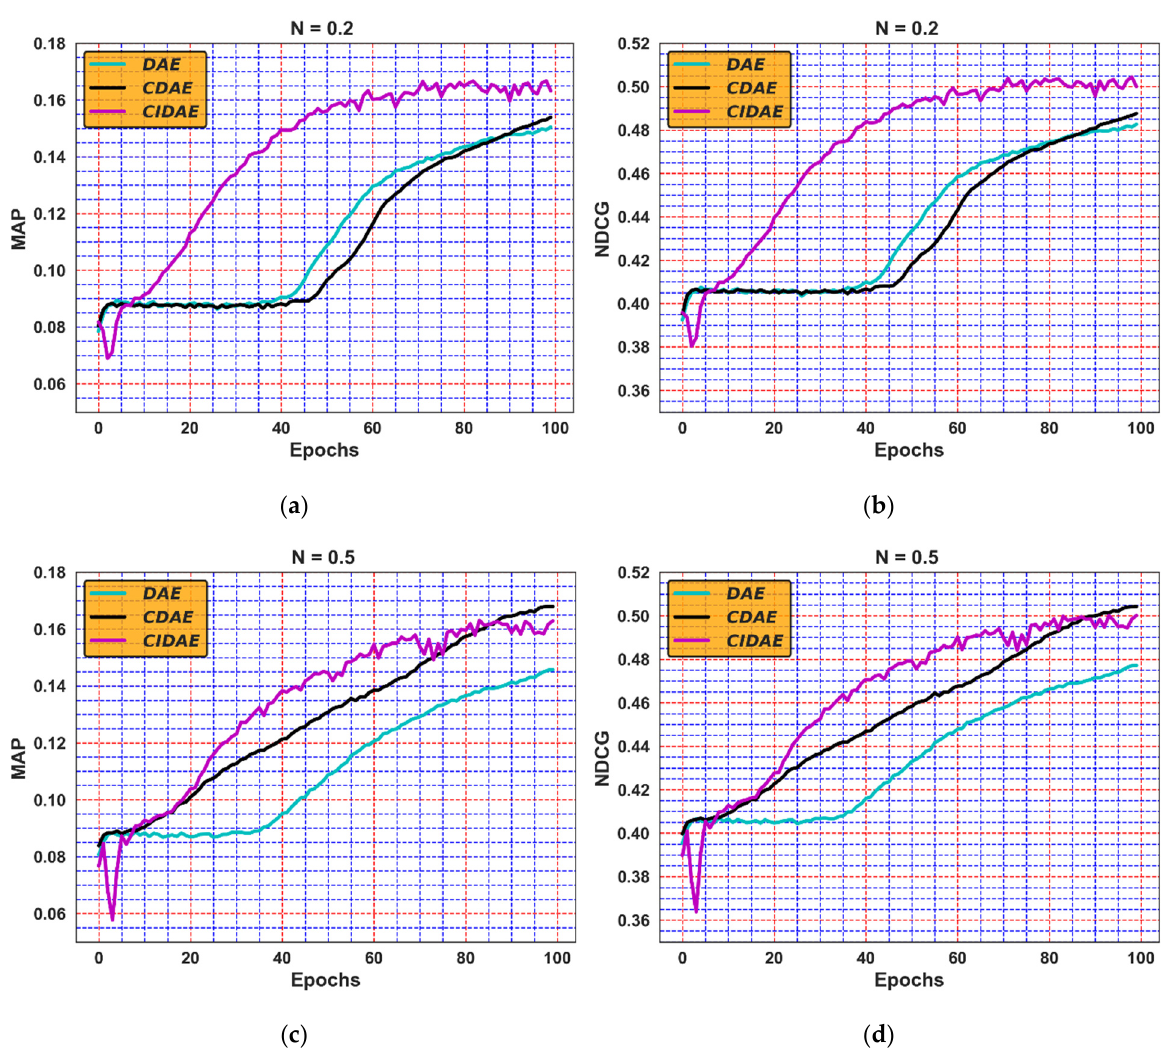
Figure 11. Performance comparisons of ML ‐ 1M through MAP and NDCG metrics.